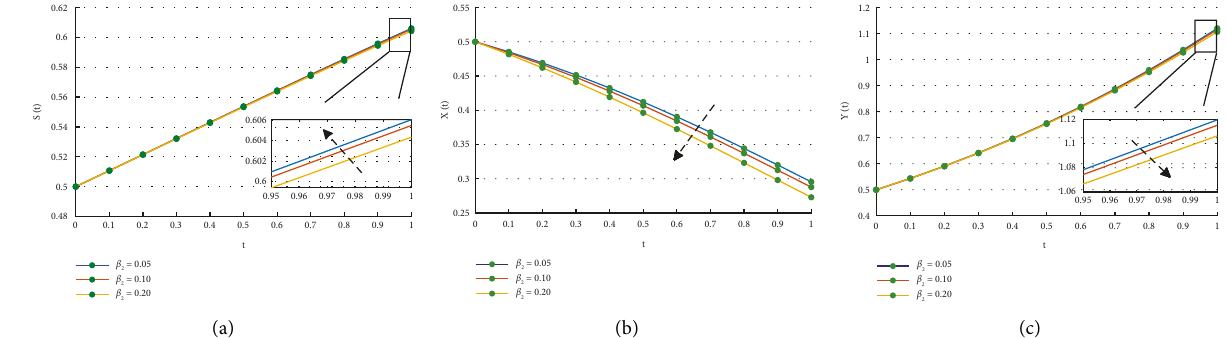
Figure 15: Comparison between solutions obtained by the LeNN-WOA-NM algorithm under the influence of variations in β population densities of the prey-predator model. (a) Approximate solutions for population density of local prey. (b) Approximate solutions for population density of immigrant prey. (c) Approximate solutions for population density of the predator.